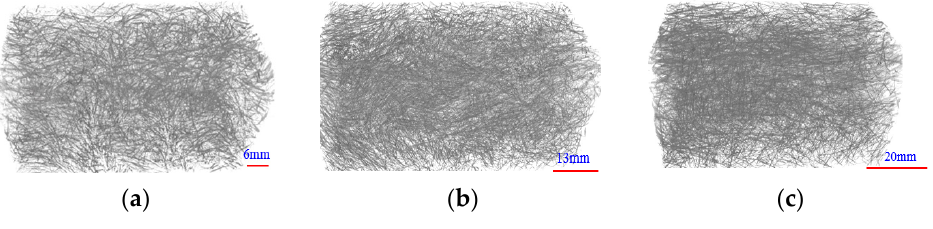
Figure 2. The distribution of steel fiber in UHPC. ( a ) 6 mm; ( b ) 13 mm; ( c ) 20 mm. Table 2. Physical properties of the steel fibers. Table 3. Mix proportion of the UHPC mixture with a fiber volume fraction of 2.0% (kg/m 3